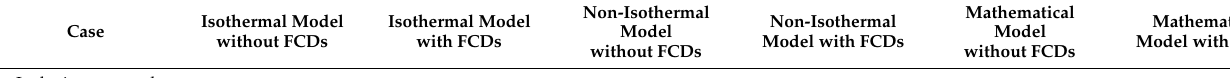
Table 6. Effect on inclusion removal ratio of molten steel in tundish.